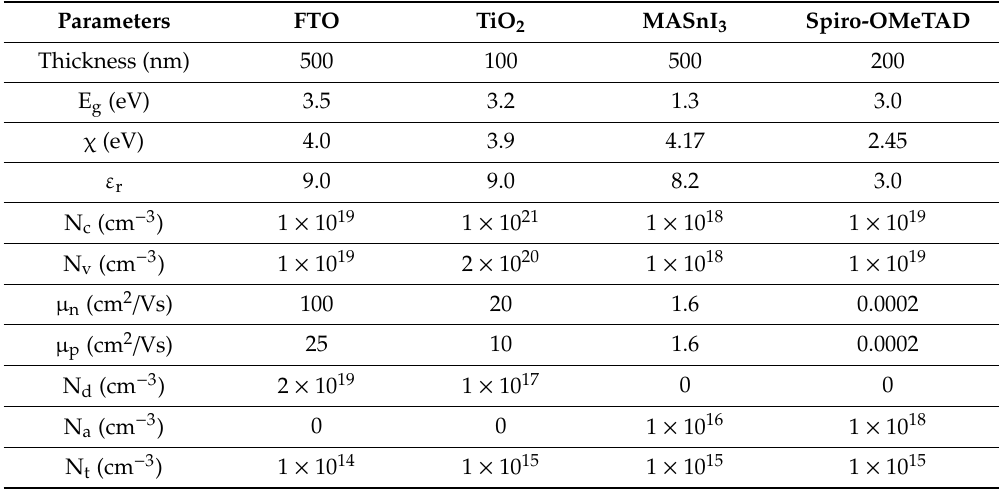
Table 1. Input parameters for simulation of PSC performance.